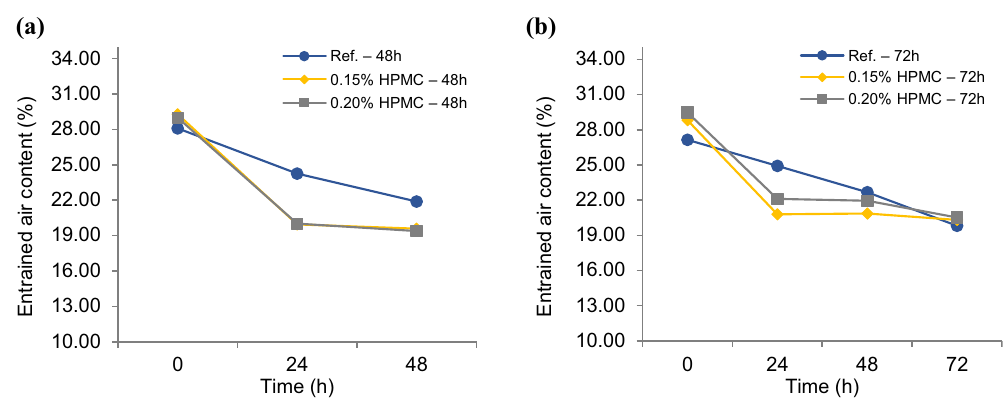
Figure 9: Evaluation of entrained air content over time for mortars. ( a ) 48 h; ( b ) 72 h.